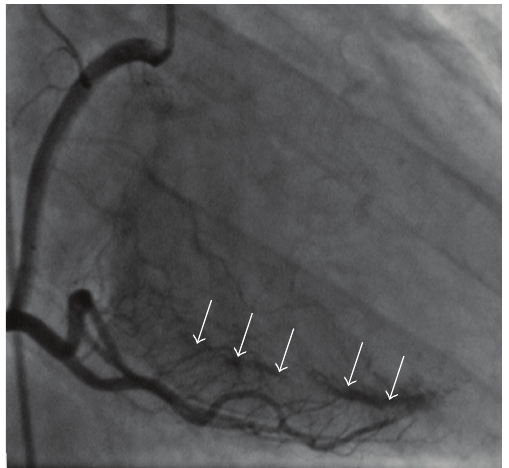
Figure 5: Selective coronary angiography shows multiple fistulae from the middle and distal right coronary artery to the left ventricle (arrows).